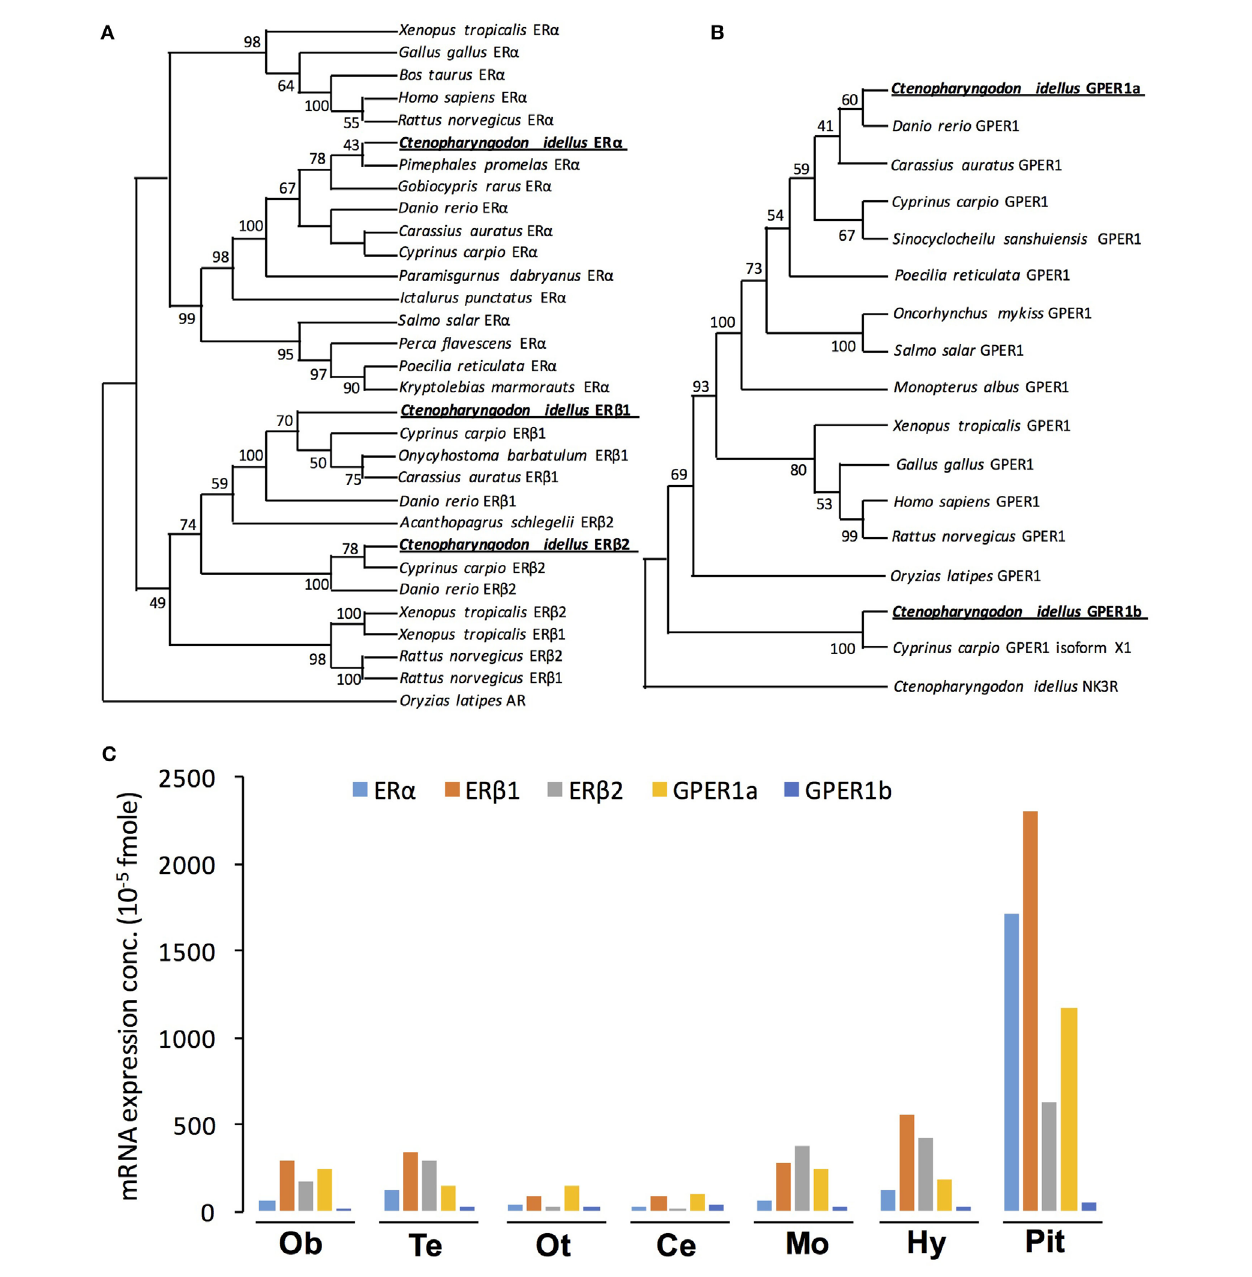
FigUre 1 | Phylogenetic analysis and tissue distribution of ERs and protein-coupled estrogen receptors (GPERs) in grass carp. (a) Phylogenetic analysis of ER amino acid sequences in vertebrate species using neighbor-joining method with MEGA6.0. The Oryzias latipes AR was used as the outgroup. (B) Phylogenetic tree of grass carp GPER using predicted amino acid sequences using neighbor-joining method with MEGA6.0 program. NK3R from grass carp served as an outgroup to root the tree. (c) Tissue distribution of estrogen receptor alpha (ER α ), estrogen receptor beta 1 (ER β 1), estrogen receptor beta 2 (ER β 2), GPER1a, and GPER1b in grass carp brain areas. Total RNA was isolated from brain areas in grass carp and subjected to reverse transcription PCR (RT-PCR) using primers specific for carp ER α , ER β 1, ER β 2, GPER1a, and GPER1b transcripts, respectively. Parallel RT-PCR for β -actin was also conducted to serve as the internal control.